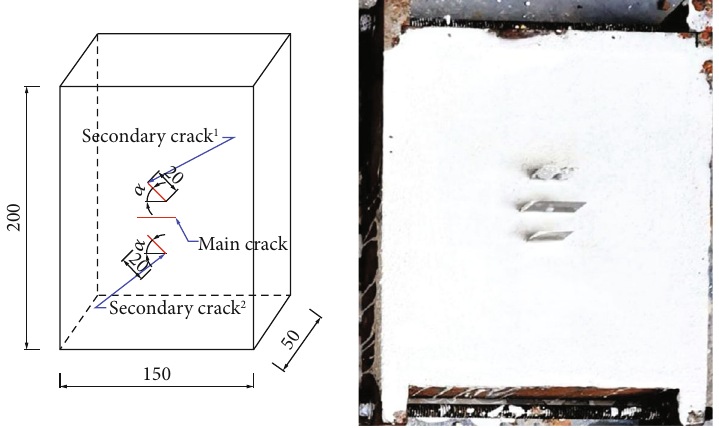
Figure 2: Model and production diagram of a group B specimen (in units of mm).